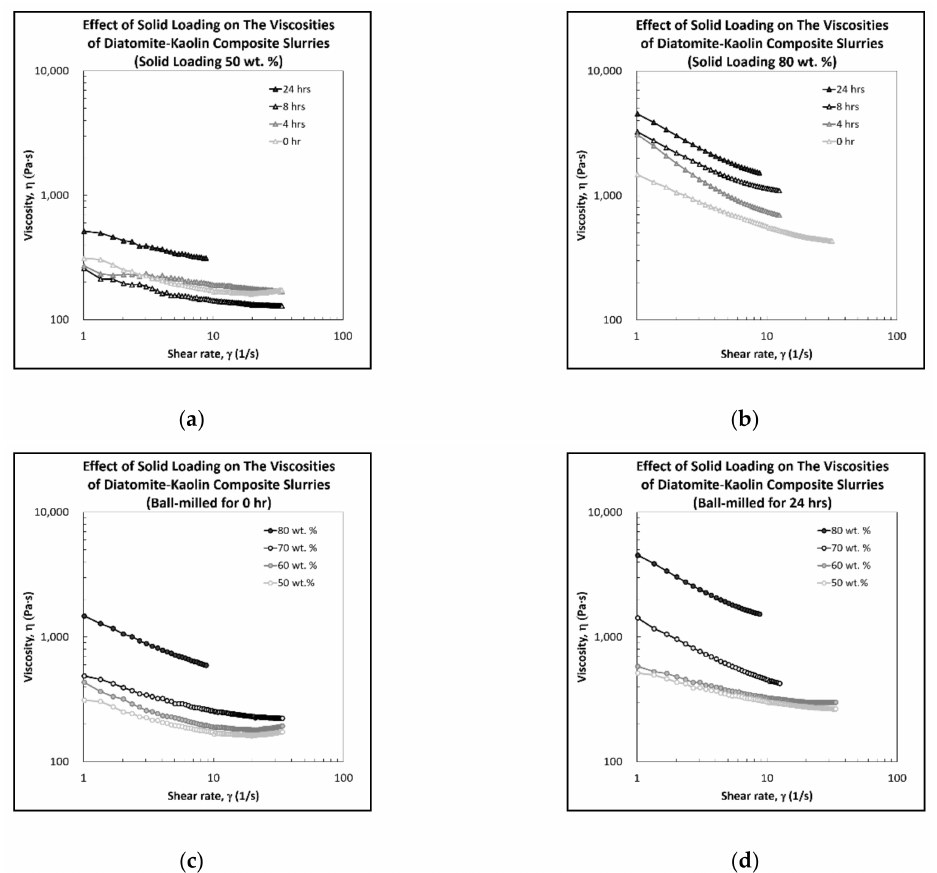
Figure 6. Viscosities of diatomite–kaolin composite slurries used for the preparation of reticulated porous diatomite–kaolin composite: ball milled for 0, 4, 8, and 24 h at a solid loading of ( a ) 50 wt.%, ( b ) 80 wt.%, ( c ) ball milled for 0 h at solid loadings ranging from 50 to 80 wt.%, ( d ) ball milled for 24 h at solid loadings ranging from 50 to 80